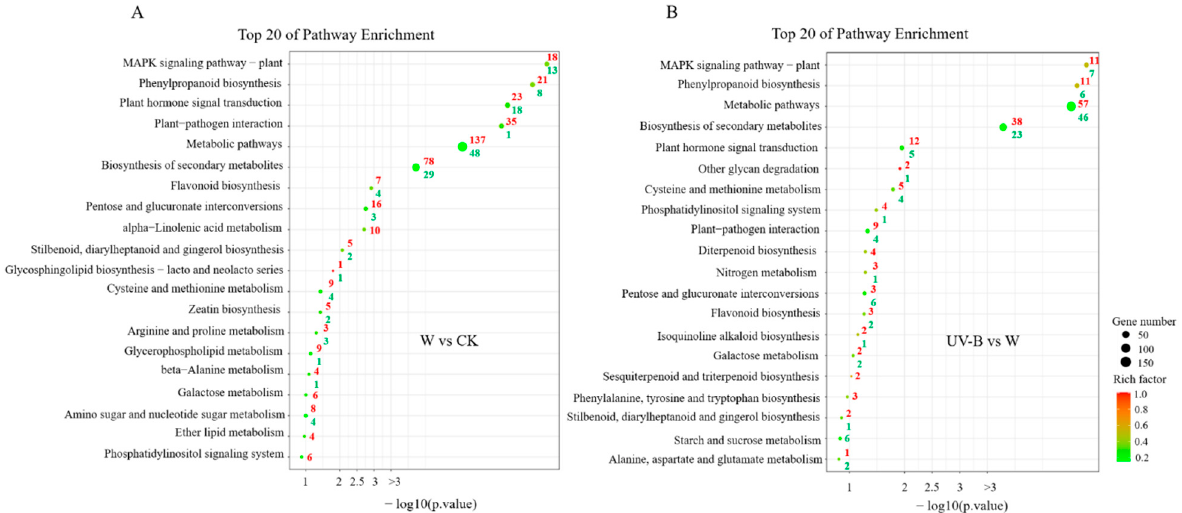
Figure 4. KEGG pathway enrichment analysis of DEGs. ( A ) The pairwise comparison of W versus CK. ( B ) The pairwise comparison of UV ‐ B versus W. Red color indicates the number of upregulated genes in each KEGG pathway; green indicates the number of down regulated genes in each KEGG pathway, respectively. Rich factor indicates the ratio of the number of DEGs located in each pathway to the number of all annotated genes in the same pathway.